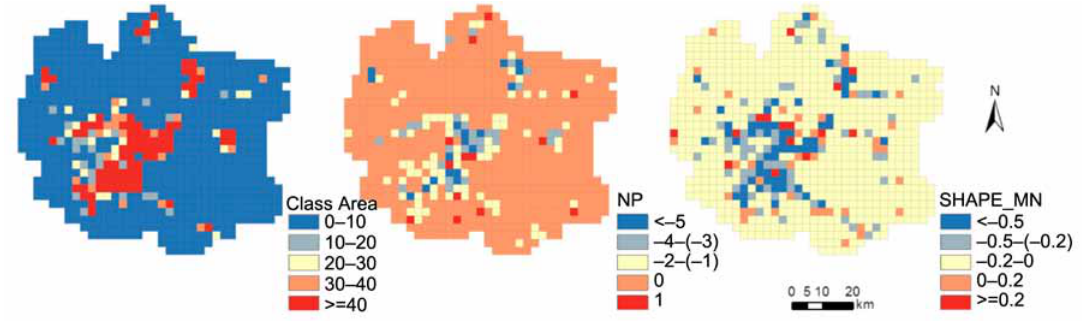
Fig. 16. Binary comparison between MDS scenario and observed landscape pattern 2010 in Class Area, NP, and SHAPE_MN